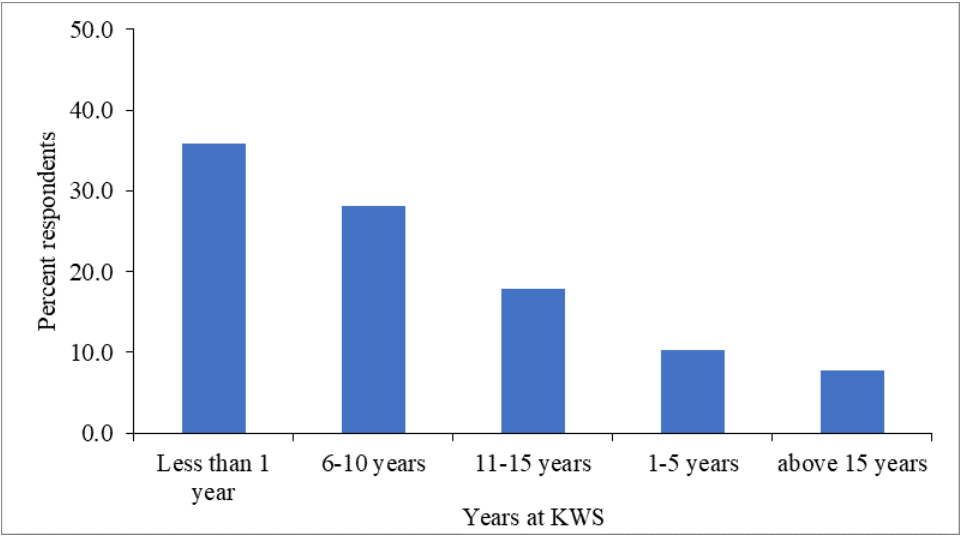
Figure 3. Proportion of respondents in response categories for number of years in the organization.